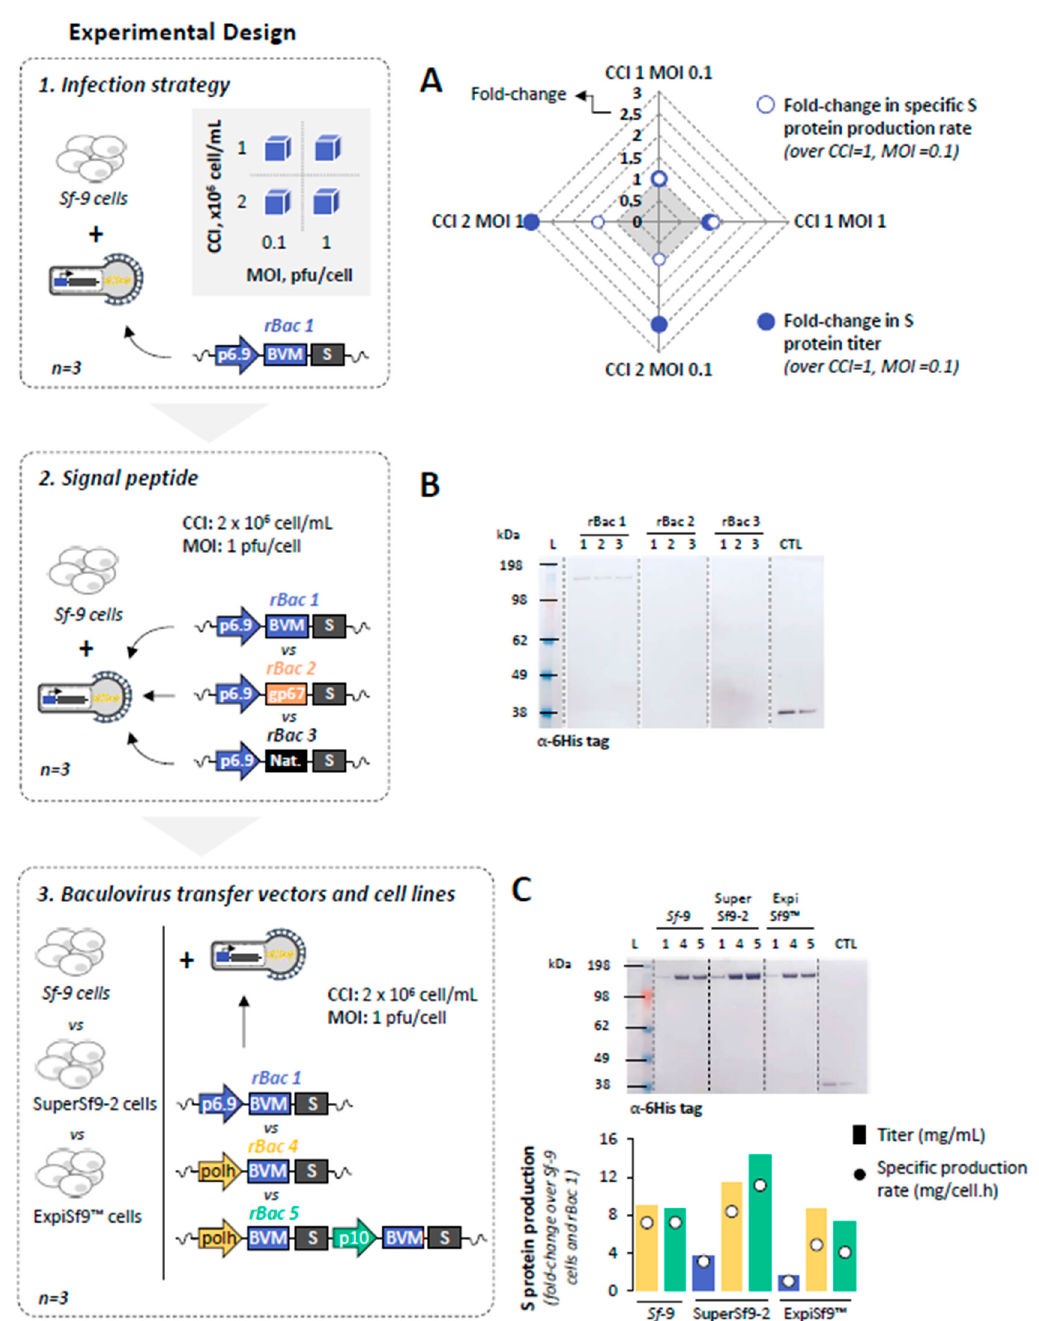
Figure 1. Production of SARS-CoV-2 spike (S) protein in small-scale shake flasks. ( A ) S protein titers and specific production rates at different cell concentrations at infection (CCIs) and multiplicity of infections (MOIs). ( B ) Identification of S protein in culture supernatant samples collected at time of harvest by Western blot; numbers 1–3 denote culture replicates. ( C ) Identification of S protein in culture supernatant samples collected at time of harvest by Western blot; numbers 1, 4 and 5 denote rBAC used ( upper panel), and S protein titers (bars) and specific production rates (circles) using different cell lines and baculoviruses ( lower panel). Color code: blue, yellow and green represents data using rBAC 1, 4 and 5, respectively. For Western blot analysis, a mouse monoclonal 6-Histag antibody was used; positive control (CTL) is an in-house purified protein with a hexahistidine tag in the C-terminal at 0.2 and 0.1 μ g; Ladder (L) is SeeBlue™ Plus2 Pre-stained Protein Standard. The expected MW of S protein monomer is approximately 140 kDa. Data are expressed as mean ± standard deviation (relative to three biological replicates, n = 3).